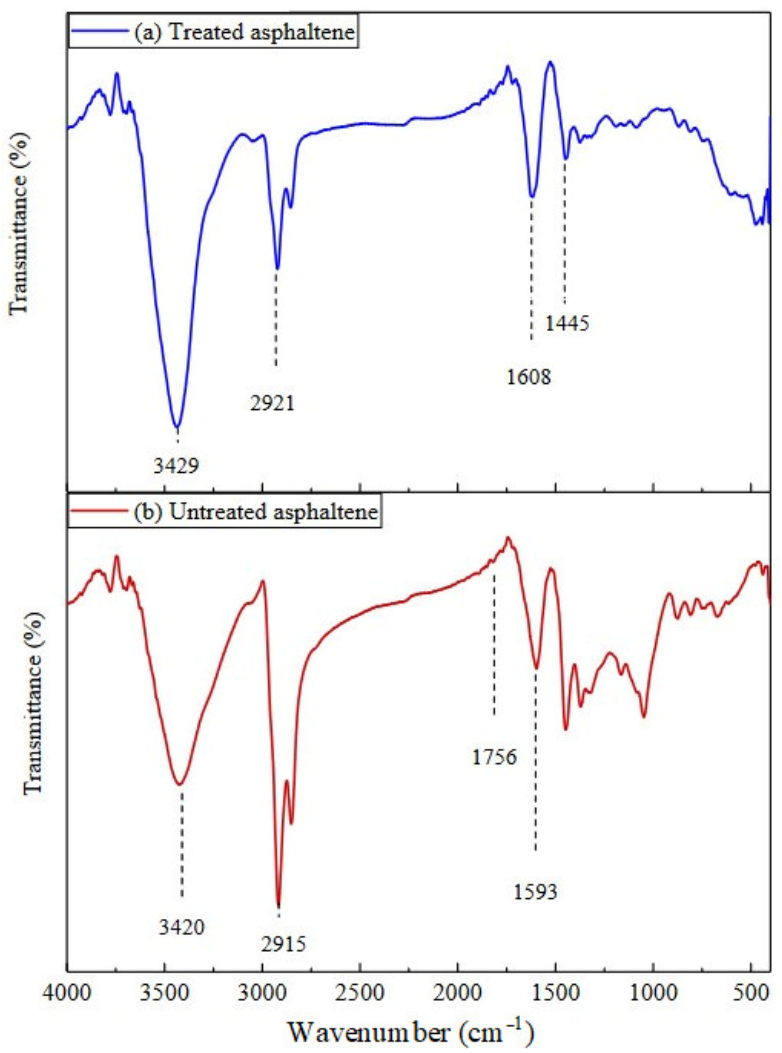
Figure 3. FT-IR spectra of ( a ) treated asphaltenes and ( b ) untreated asphaltenes before and after catalytic aquathermolysis.